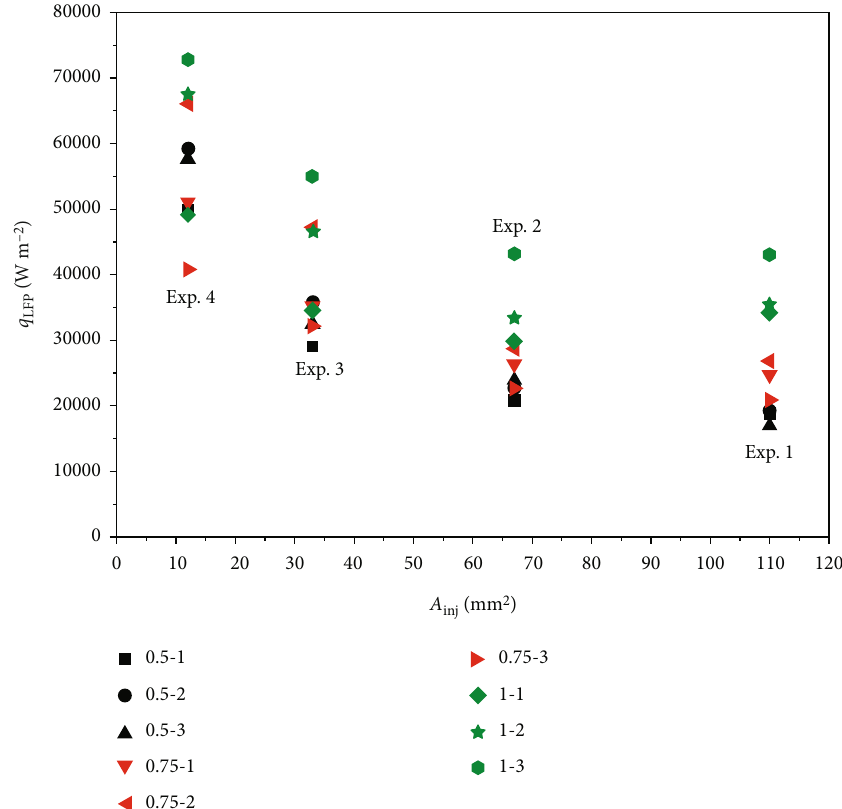
Figure 11: Experimental q